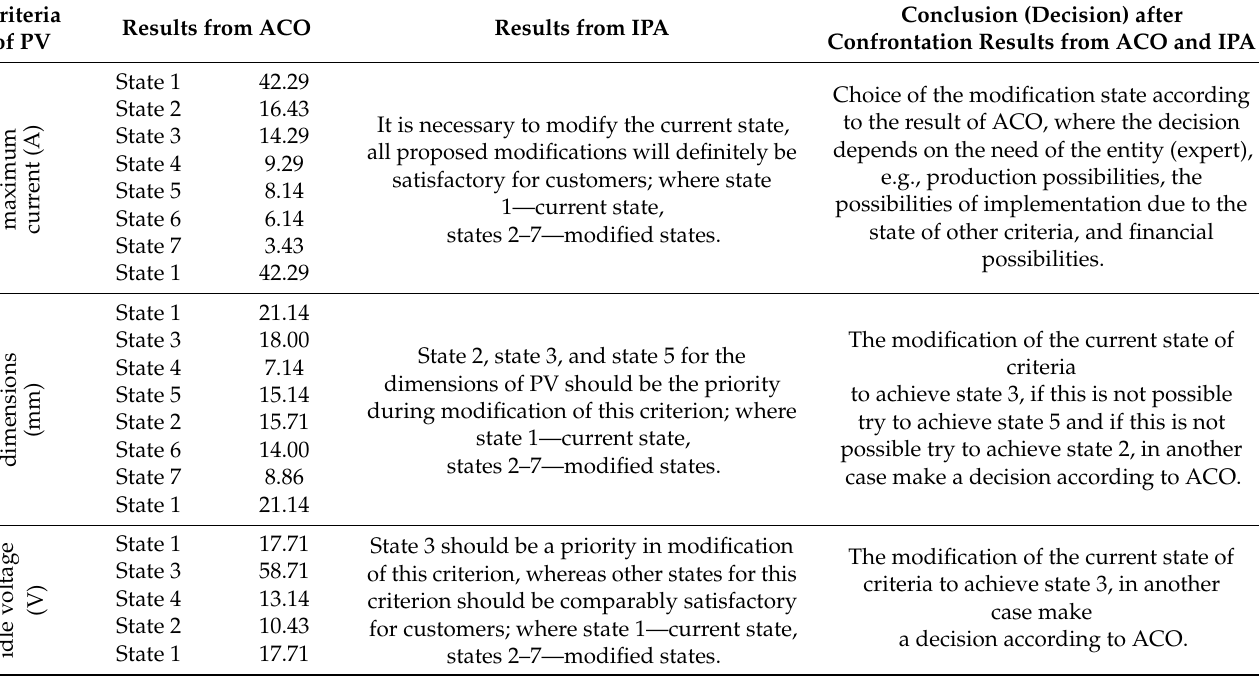
Table 7. Confrontation results of the model to support the process of improving